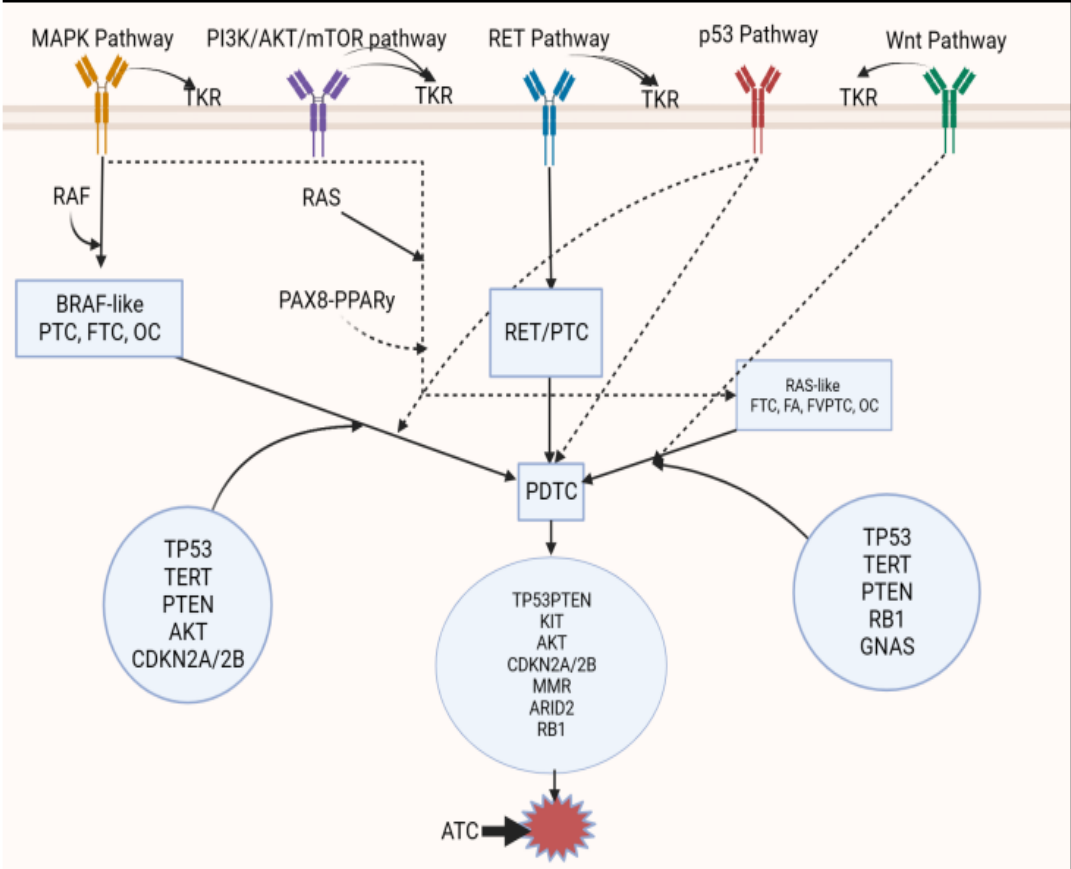
Figure 2. Pathways in the development, progression, metastasis, and de-differentiation of follicular neoplasms of the thyroid. The initiating event may be a gain mutation or re-arrangement in the genes that regulate the transmembrane tyrosine kinase receptors or involve intracellular kinases. The MARK , PI3K/AKT/mTOR and RET pathways are involved in the early phase of tumorigenesis. The RAS mutation is an upstream event for FTC, FA, FVPTC, and rarely PTC. RAF mutations are seen more frequently in PTC. The p53, Wnt , PTEN , TERT, and other mutations or rearrangements occur later as WDTC progresses towards PDTC or ATC. (Created using BioRender.com accessed on